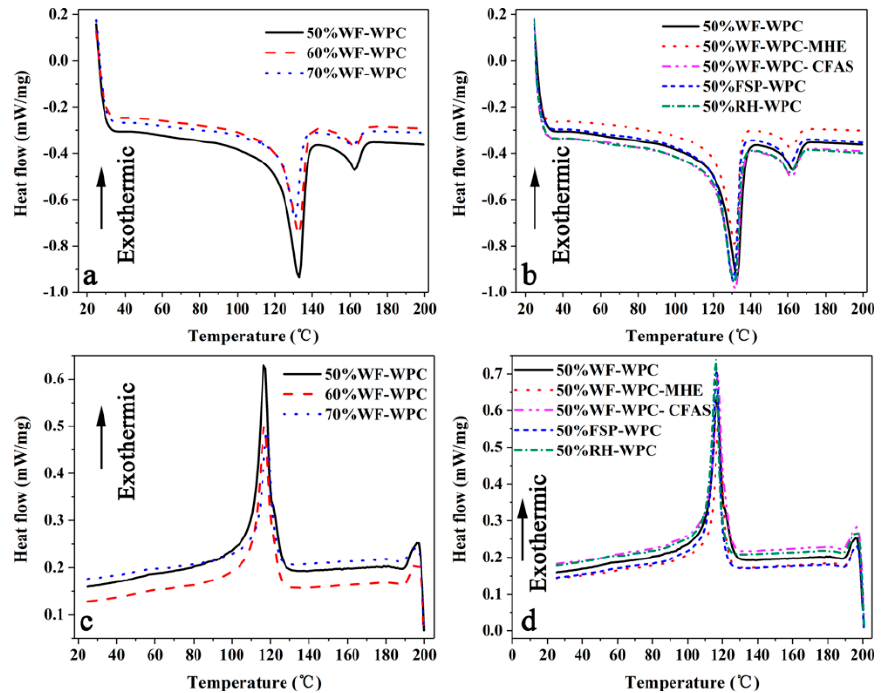
Figure 2. DSC curves for the WPCs ( a , b —melting process; c , d —crystallization process).